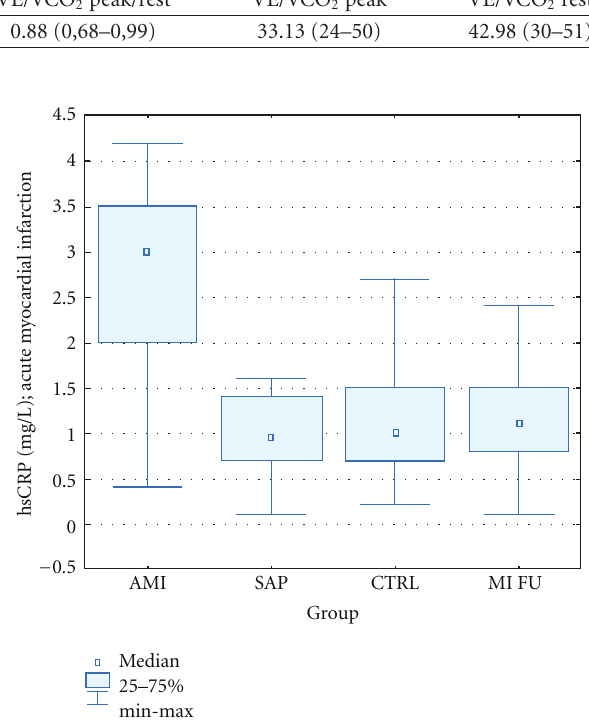
Figure 11: Plasma hsCRP levels. Patients: with acute myocardial infarction: AMI, with stable angina pectoris: SAP, control group: CTRL, 1-year followup: MI FU. P = 0,47 SAP versus CTRL; P < 0,0001 AMI versus CTRL; P < 0,0001 AMI versus SAP; P = 0,21 MI F-U versus CTRL; P = 0,73 MI FU versus SAP; P < 0,0001 MI F-U versus